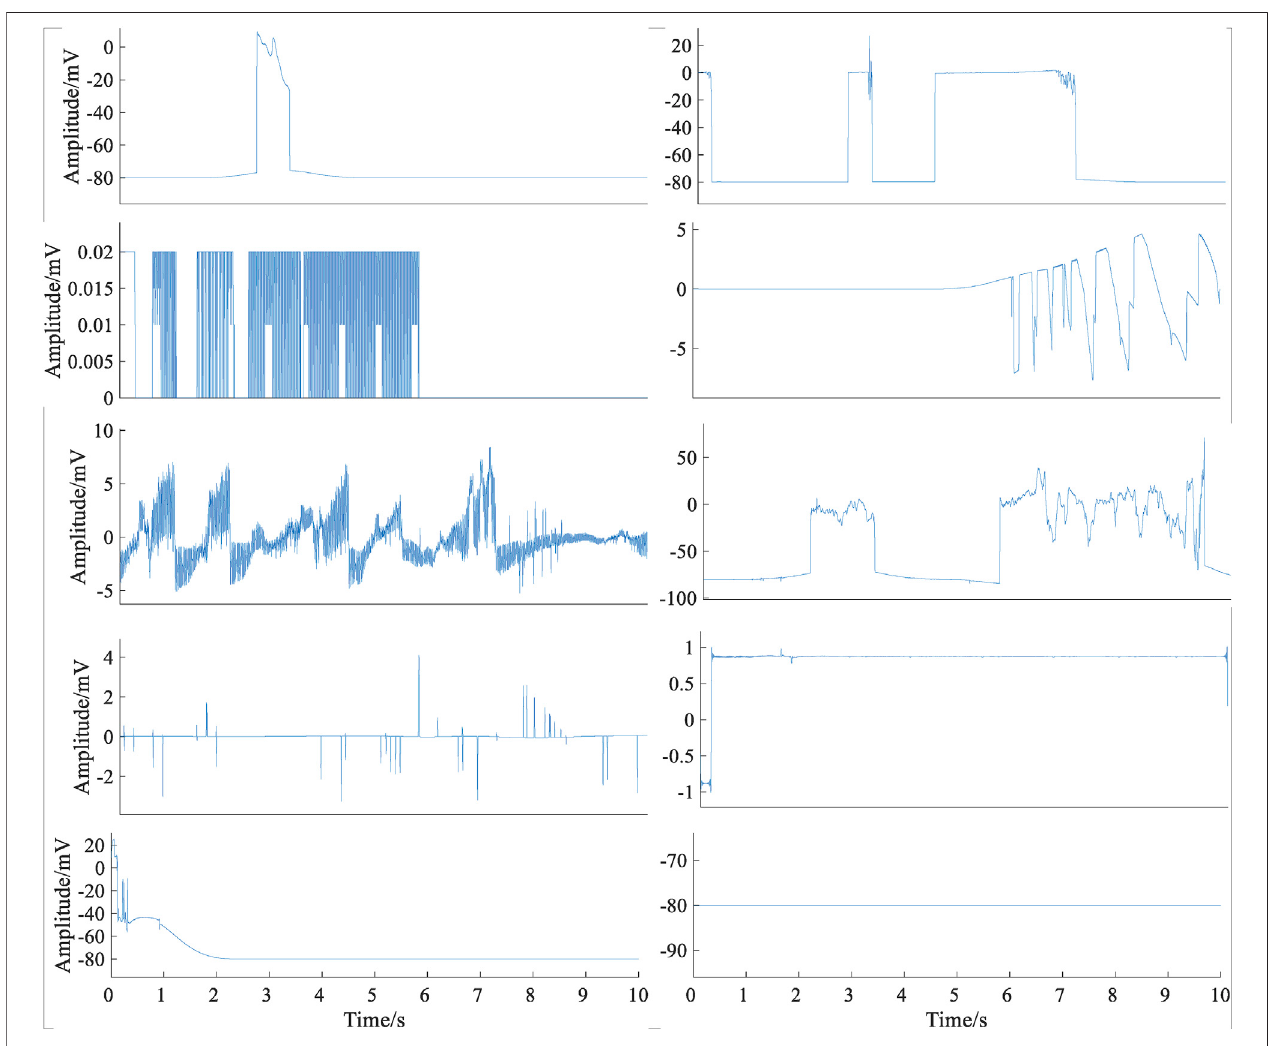
FIGURE 2 | Typical cases of lead-fall